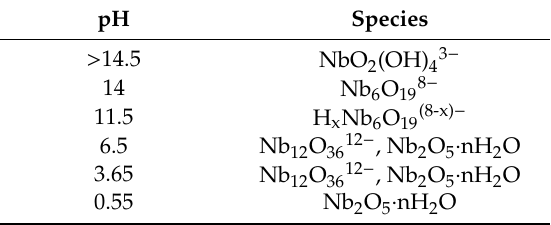
Table 11. The polymerization degree of oxoniobiate versus pH. Information taken from Ref.